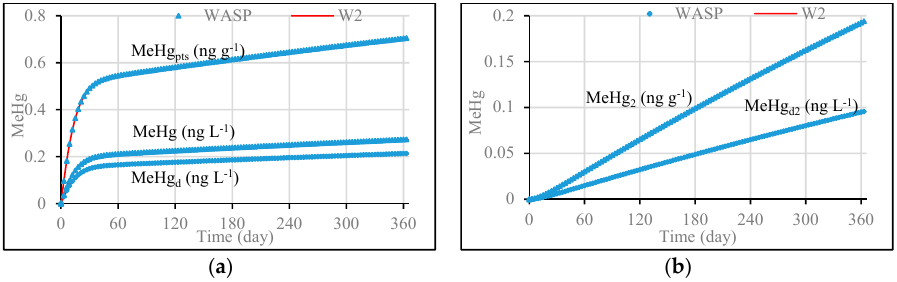
Figure 5. W2 and WASP computed MeHg distributed concentrations in the water column ( a ) and the sediment layer ( b ): MeHg (concentration of total MeHg in water); MeHg d (concentration of dissolved MeHg in water); MeHg pts (total concentration of solids adsorbed MeHg in water); MeHg 2 (concentration of total MeHg in sediment); MeHg d2 (concentration of dissolved MeHg in sediment).